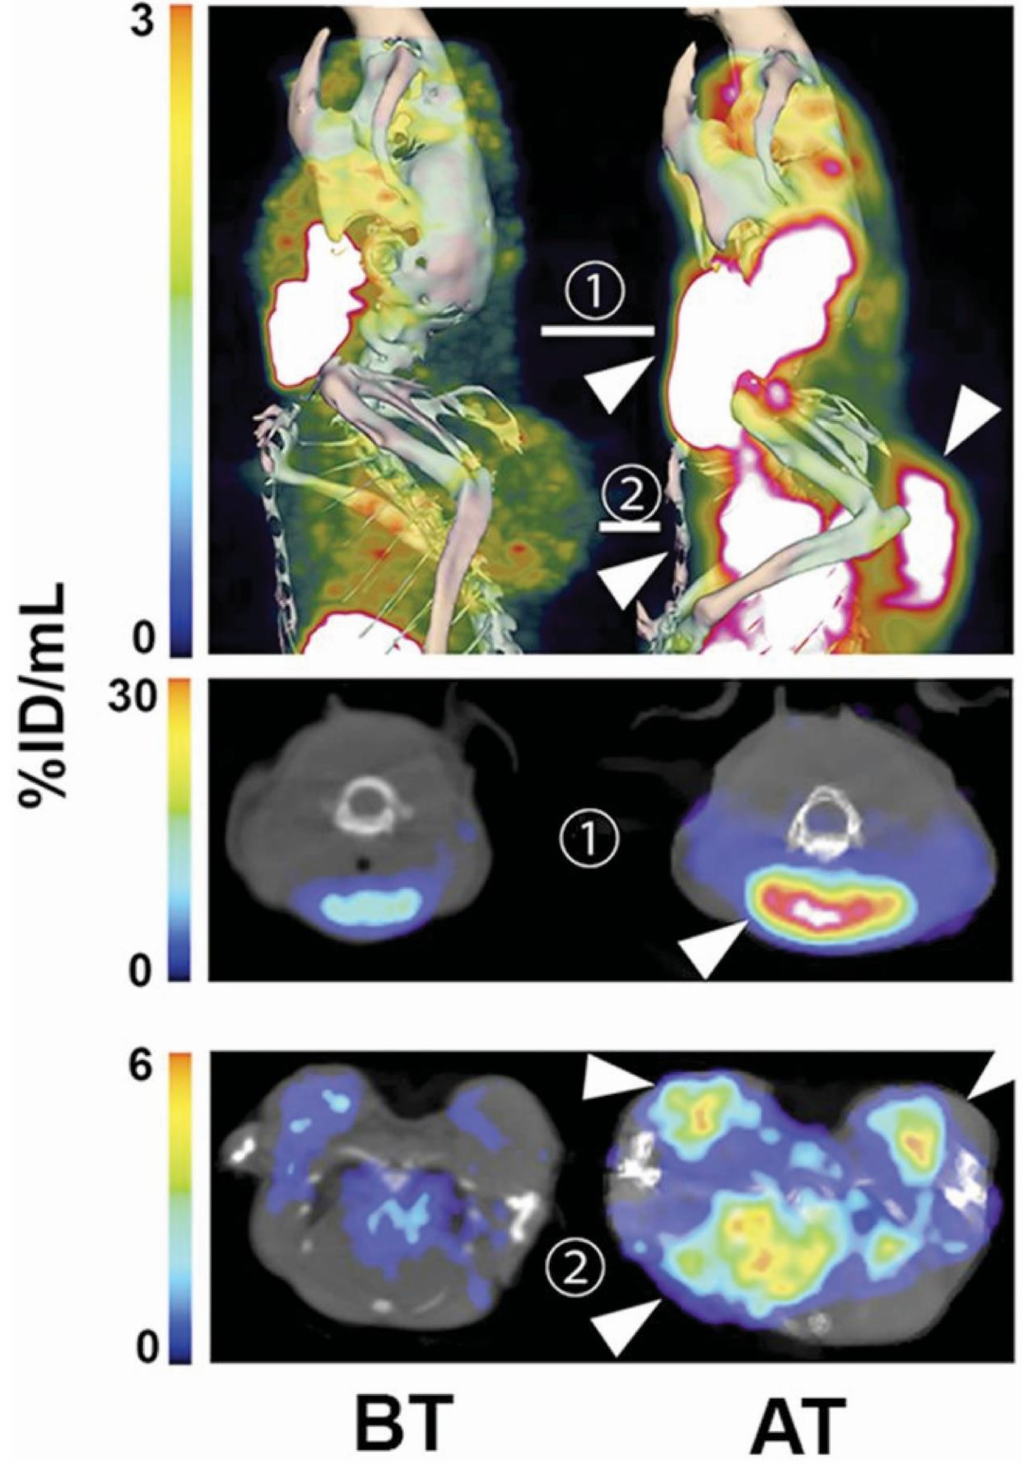
Figure 1. Single photon emission computed tomography (SPECT) imaging of cell death in vivo in E µ - Myc tumours. Imaging of ( 99m Tc)-labelled C2Am at 2 h after probe administration and 24 h after drug treatment. SPECT/CT of representative E µ - Myc mice before (BT, left) and after (AT, right) cyclophosphamide treatment. Top—maximum intensity projections (MIPs); middle—axial section through the cervical tumour; bottom—axial section through the axillary and mediastinal tumours. Tumours are indicated with arrowheads. Reproduced with permission from Neves et al. © SNMMI